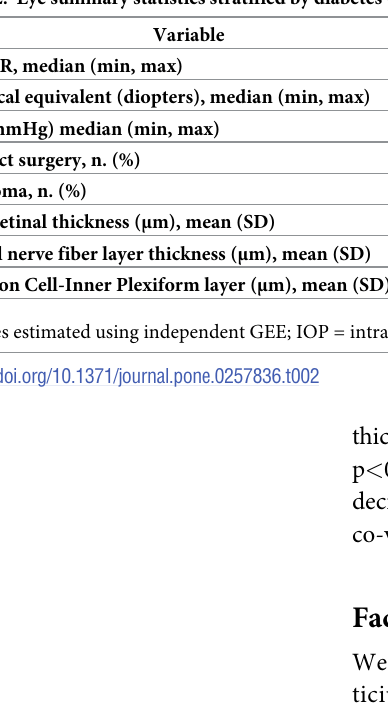
Table 2. Eye summary statistics stratified by diabetes (all included eyes).